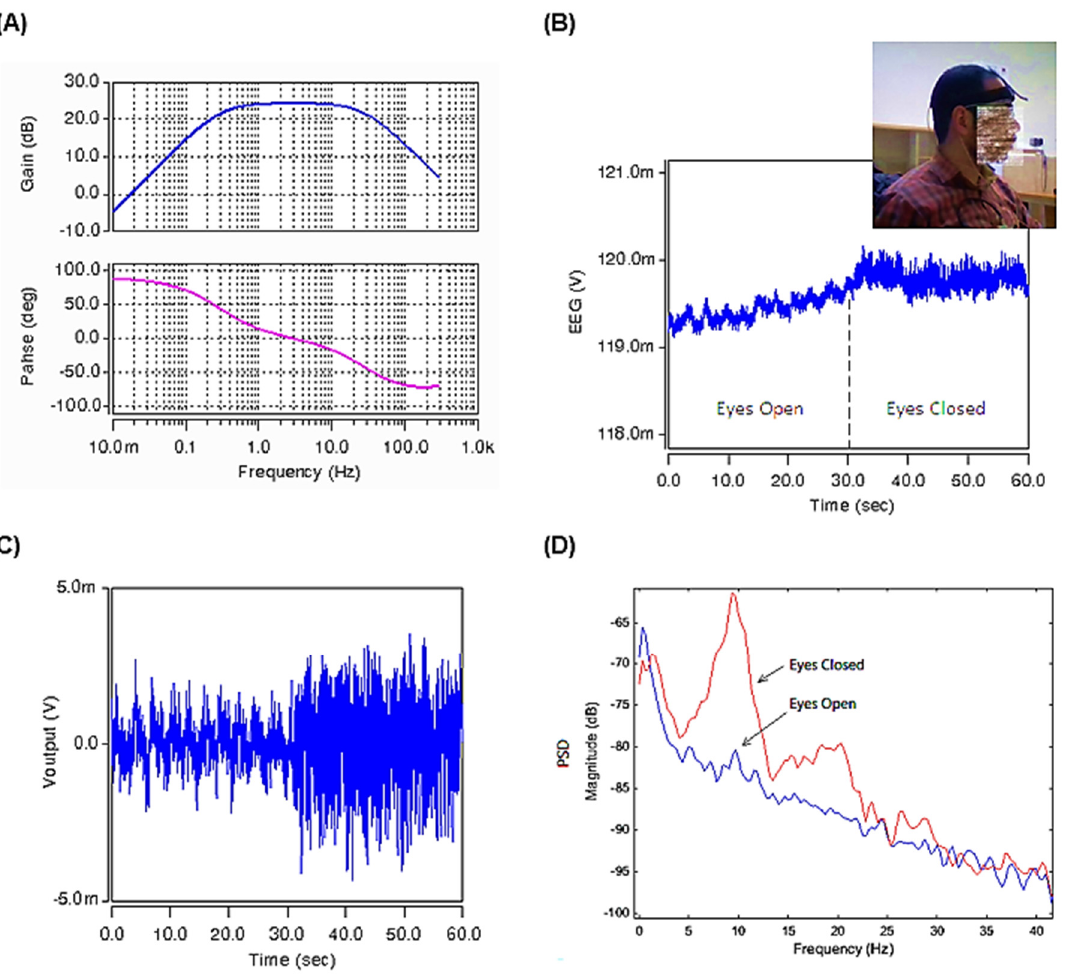
Figure 10. ( A ) The frequency response of the gain and phase of the band-pass bioamplifier. ( B ) The original EEG input signal (Vinput). ( C ) The EEG output signal after amplification and filtering using the designed circuit of Figure 8. ( D ) Power spectral density plots under eyes-open and eyes-closed conditions for the EEG recordings.